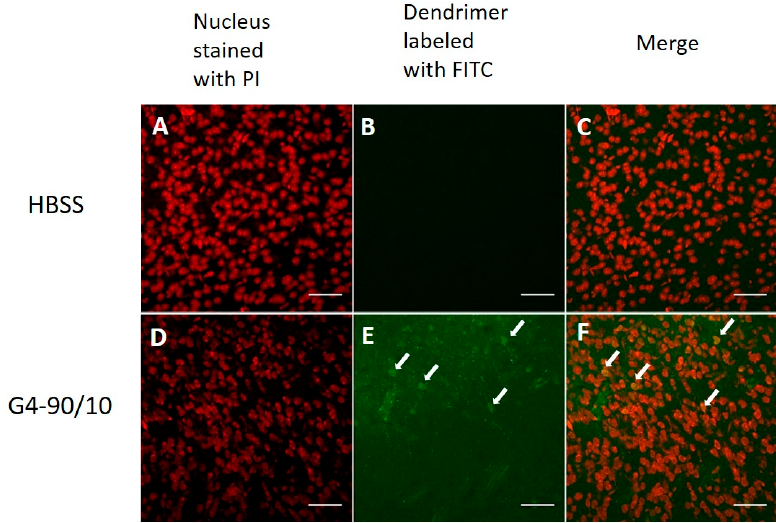
Figure 7. Confocal images of dendrimer in the brain when injected intracranially. Neurons and glial cells labeled with propidium iodide stain (red— A , D ), HBSS control and merge ( B , C ), G4-90/10 infecting cells (arrow; E ) and merge (arrow; F ). All images were taken at 40× magnification using Olympus BX50 Upright Microscope (Olympus, Shinjuku, Tokyo, Japan). Scale bar: 100 µ m.